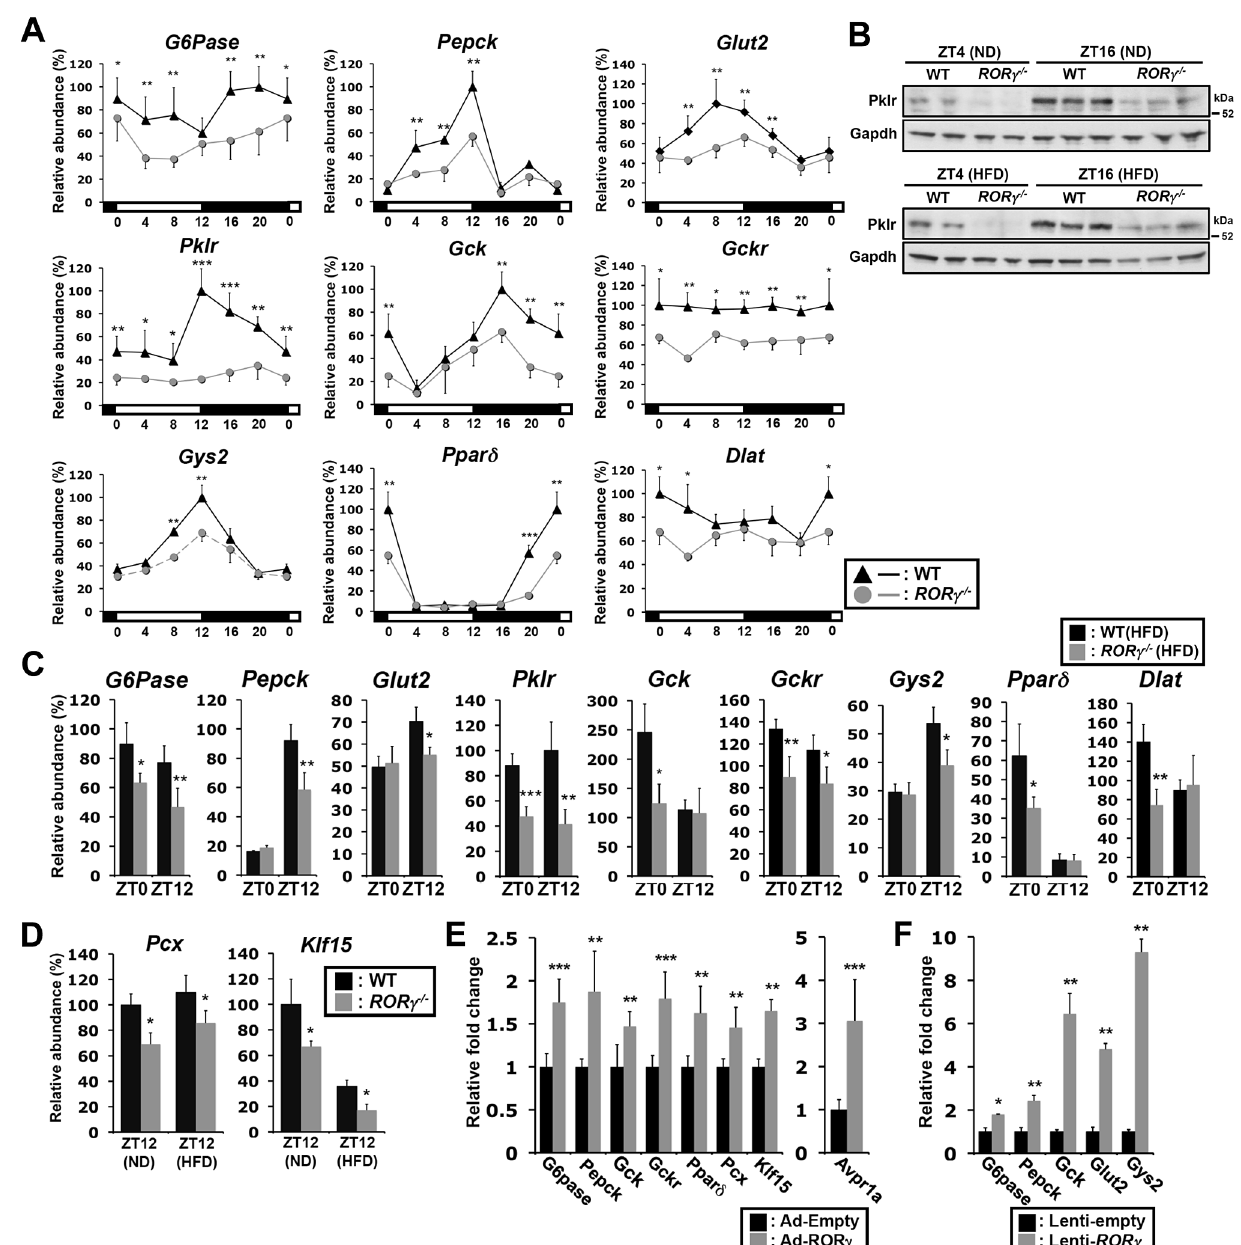
Figure 5. ROR c regulates the circadian expression of genes involved in gluconeogenesis and glycolysis pathways. ( A ) Circadian expression pattern of G6pase , Pepck , Glut2 , Pklr , Gck , Gckr , Gys2 , Ppar d , and Dlat in liver of WT(ND) and ROR c 2 / 2 (ND) mice (n=4). RNA was isolated every 4 h over a period of 24 h. ( B ) Pklr protein levels at ZT4 and ZT16 in whole liver lysates prepared from WT and ROR c 2 / 2 mice fed either a ND or HFD (n=2–3). Pklr was examined by Western blot analysis. ( C ) Differential expression of several metabolic genes in liver of WT(HFD) and ROR c 2 / 2 (HFD) mice collected at ZT0 and ZT12 (n=5). ( D ) Differential expression of Pcx and Klf15 in WT and ROR c 2 / 2 livers collected at ZT12. ( E ) Adenovirus mediated over-expressing of ROR c in ROR c 2 / 2 liver enhanced the expression of several glucose metabolic genes. ( F ) G6pase , Pepck , Gck , Glut2 , and Gys2 expression in primary hepatocytes isolated from ROR c 2 / 2 mice (n=3) infected with either empty or ROR c lentivirus. Data represent mean 6 SD, * P , 0.05, ** P , 0.01, *** P , 0.001 by ANOVA.